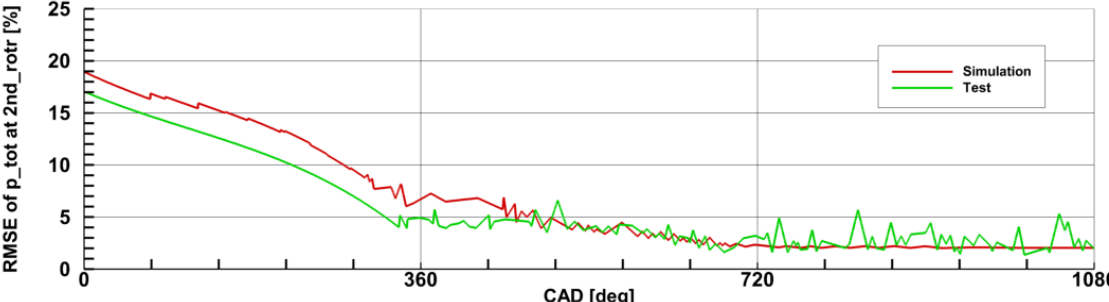
Figure 8. Numerical model validation against the experimental results using the RMSE parameter.